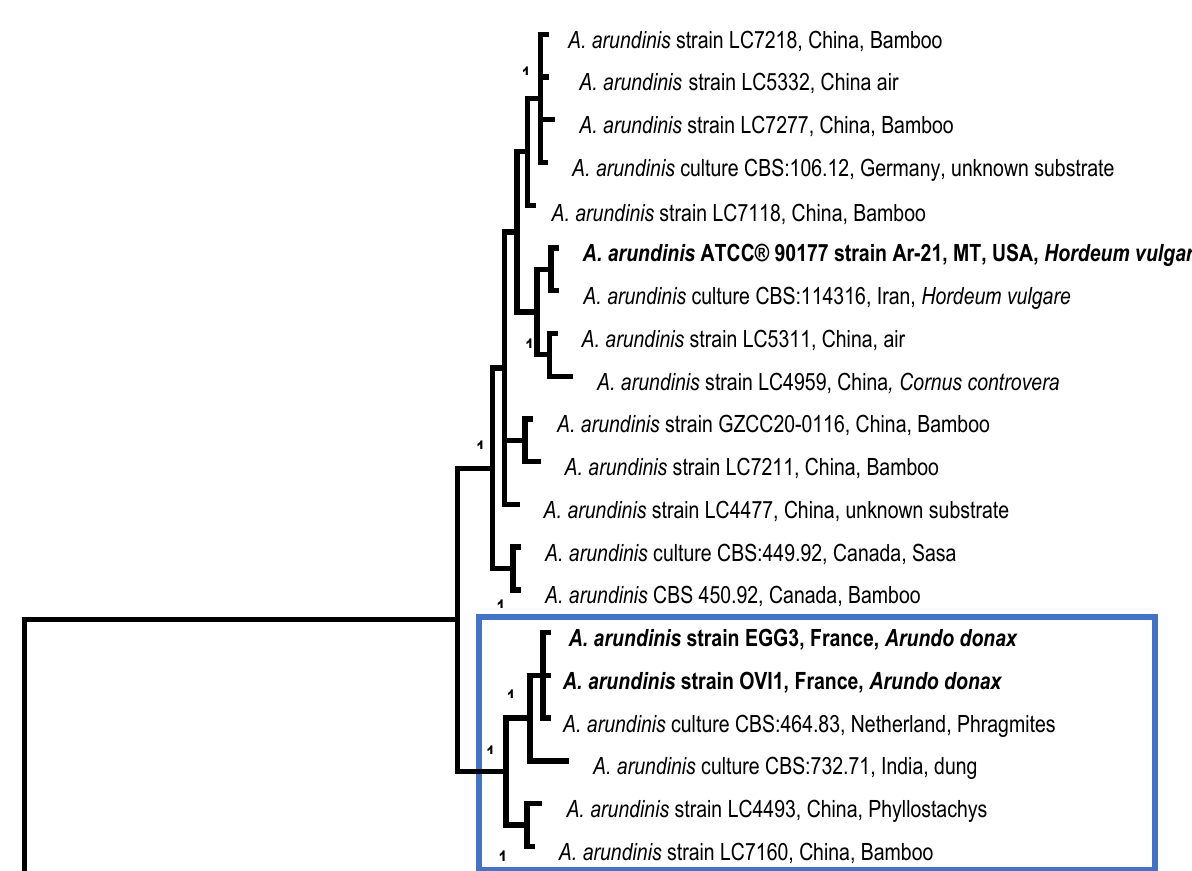
Figure 4. A 50% majority rule consensus phylogram obtained in MrBayes after the analysis of combined ITS rDNA, TUB2, and TEF1 sequences (introns included) of Apiospora arundinis . Nodes were annotated if supported by >0.95 Bayesian posterior probabilities. Bold names represent samples sequenced in the present study.